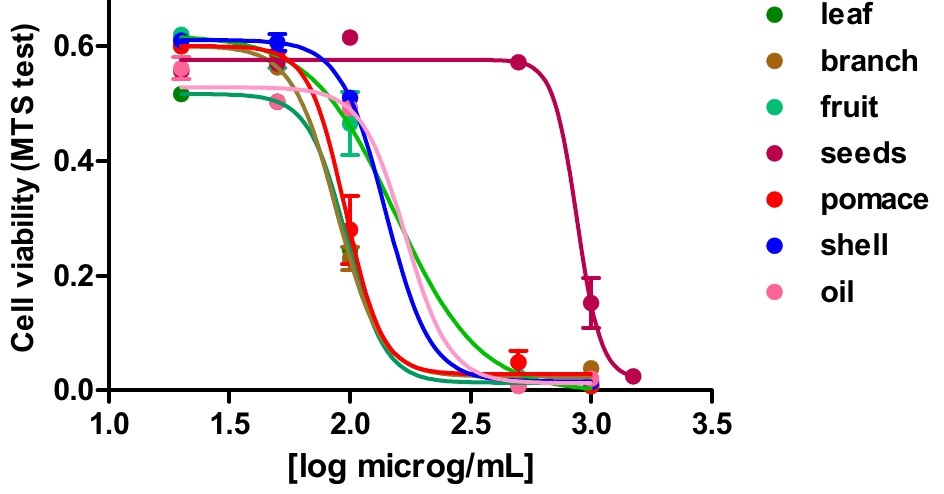
Figure 3. Dose-dependent cytotoxicity of the phenolic and triterpenoid extracts from Frantoio on HCT-116 human cancer cell line. Data are the mean ± SE of 3 independent experiments. Table 3. ( A ) IC 50 values of the phenolic and triterpenoid extracts from Frantoio cv; ( B ) IC 50 values of some representative pure phenols and triterpenoids.